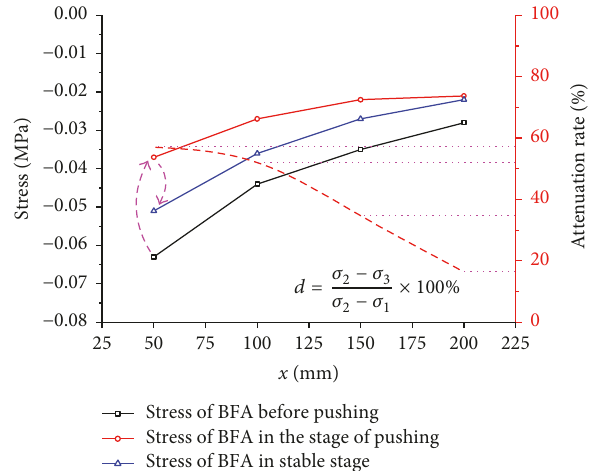
Figure 10: Stress evolution process in the loose area during pushing